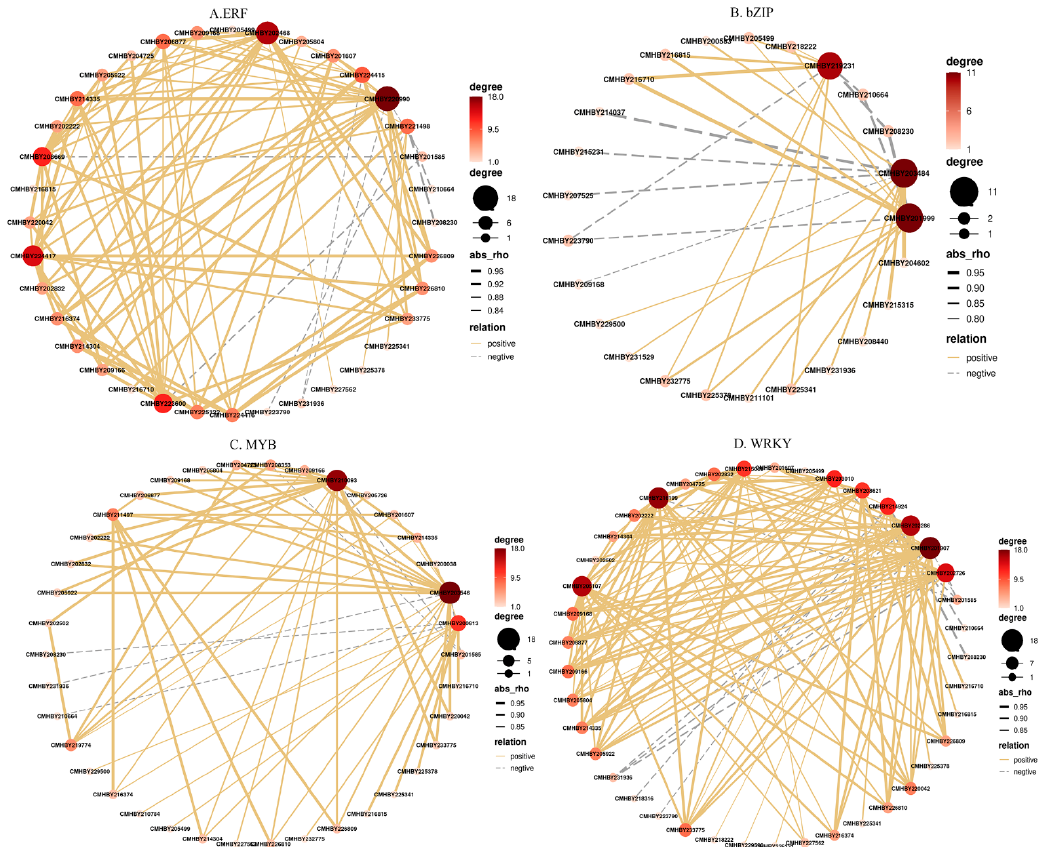
Figure 8. Correlation of expression profiles between the four TF families (( A ) ERF; ( B ) bZIP; ( C ) MYB; and ( D ) WRKY) and starch biosynthesis-related genes. Solid yellow lines denote positive and dotted gray lines represent negative correlation; dot size/color denotes the quantity of correlated objects.